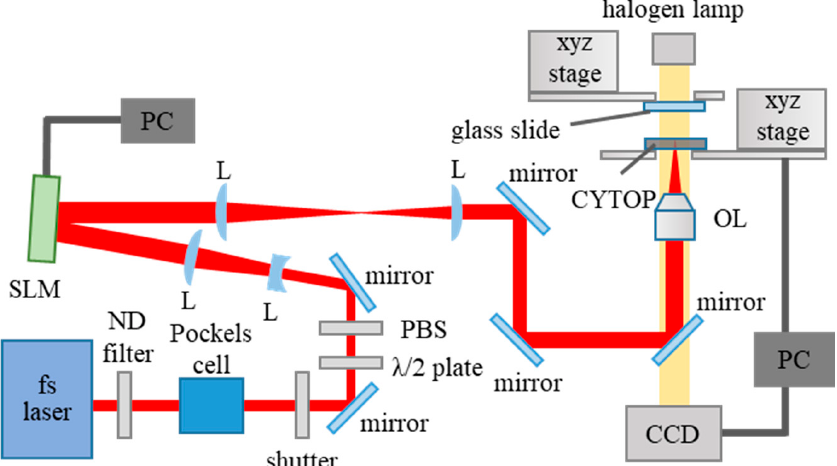
Figure 1. Schematic of the holographic femtosecond (fs) laser processing setup for CYTOP nanoparticle (NP) deposition. (OL: objective lens, L: lens, PBS: polarization beam splitter).